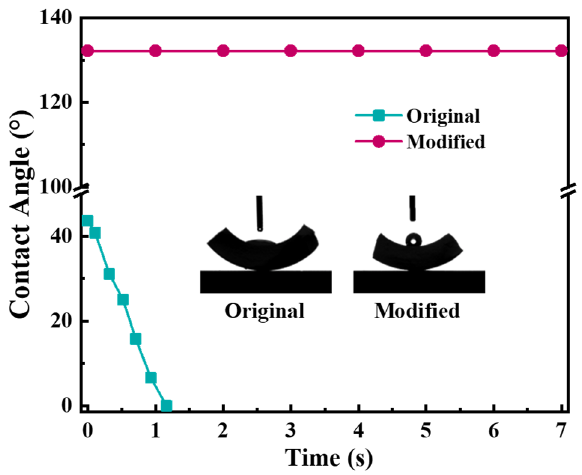
Figure 7. The water contact angle of the ceramic membrane before and after modification.